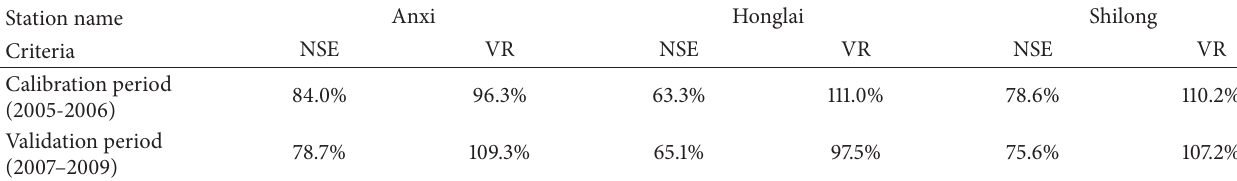
Table 3: Model performance at three streamflow